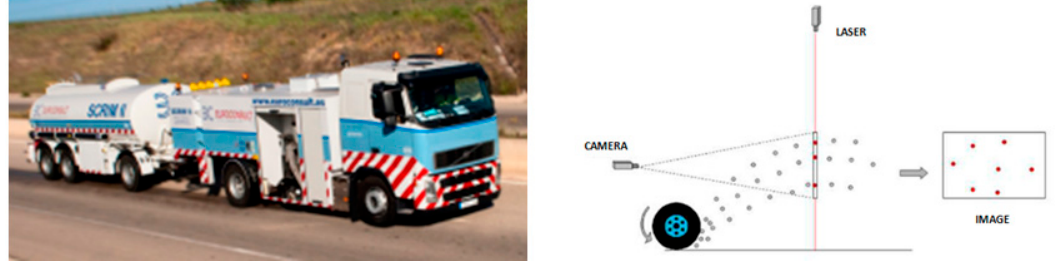
Figure 2. Splash and spray trailer and measuring details.